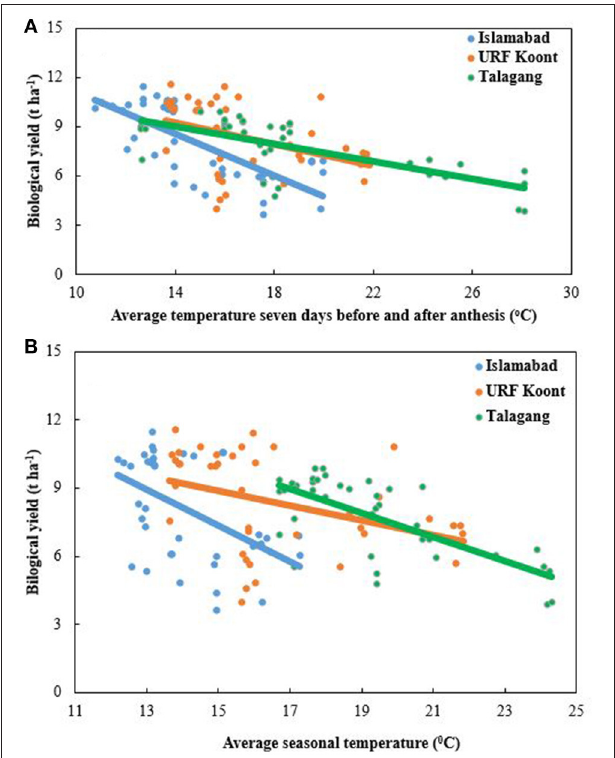
FIGURE 4 | Trend line for grain yield at Islamabad, URF Koont and Talagang including four sowing dates and 2 years as a function of (A) average temperature 7 days before and after anthesis, and (B) average seasonal